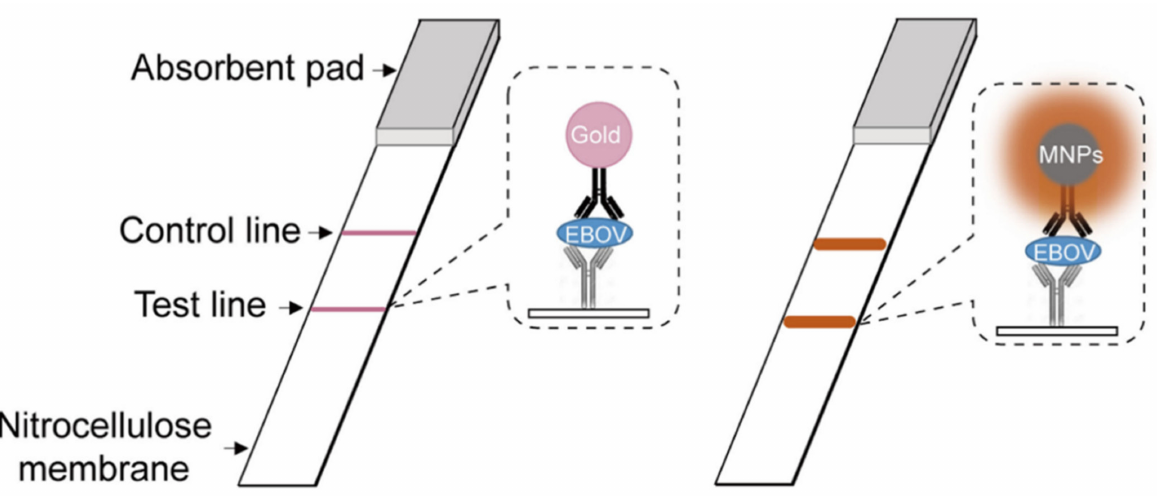
Figure 1. Schematic illustration of Fe 3 O 4 nanozyme-strip for the detection of EBOV. Adapted from ref [18], with permission from Copyright © 2015, Elsevier B.V. All rights